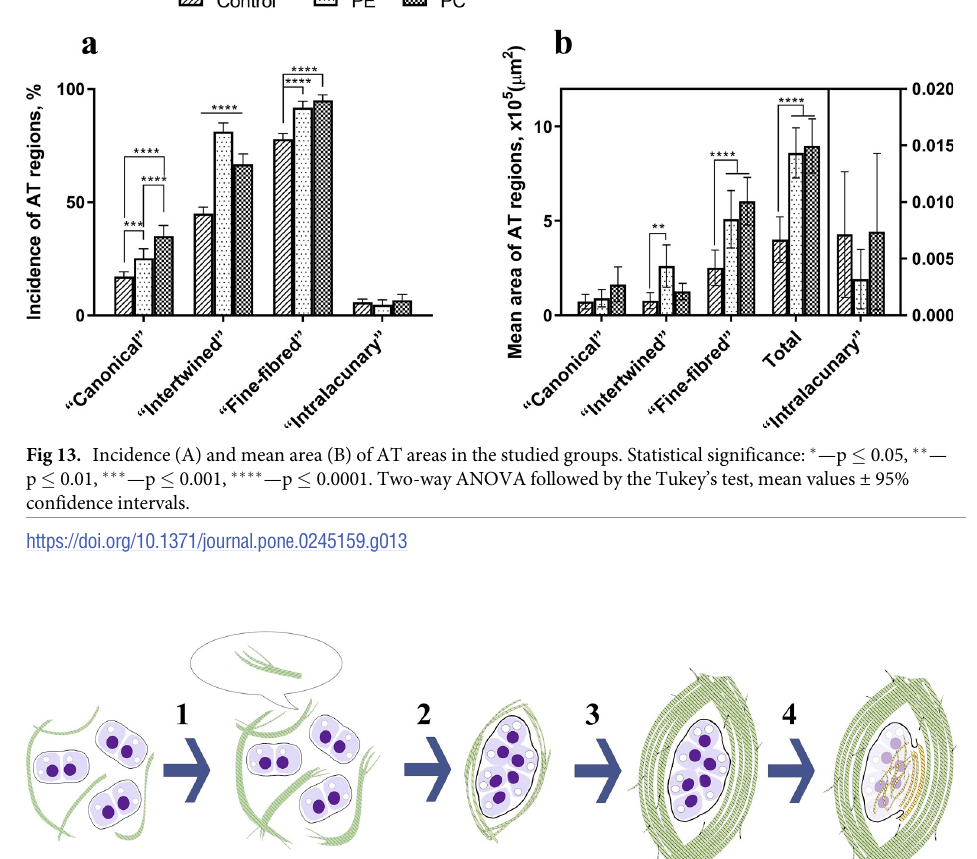
S1 Fig. Spatial relationships and degenerative changes in various types of AT areas in cos- tal cartilage matrix, hematoxylin and eosin, × 1000. Often, different types of matrix did not have clear boundaries and mixed with each other, forming intermediate, or transitional, forms. The "canonical" (CAN) and "intertwined" (IT) AT areas were separated from the intact matrix (IM) by the "fine-fibred" (FF) AT area. Upon the destruction of the capsule of degener- ating cartilaginous lacunae in AT areas of the "canonical" and "intertwined" types, the contents of the lacunae merged with the surrounding matrix. "Intralacunary" (IL) AFs merged with the AFs of these two types of the AT. Amorphous basophilic contents of lacunae, cellular detritus, were observed as “puddles” in the AT areas of the “canonical” and “intertwined” types. These "puddles" could contain the foci of lysis of the "canonical", "intertwined" or "intralacunary" AFs, as well as cartilaginous lacunae. Such changes did not occur in the intact matrix or in the "fine-fibred" AT areas.